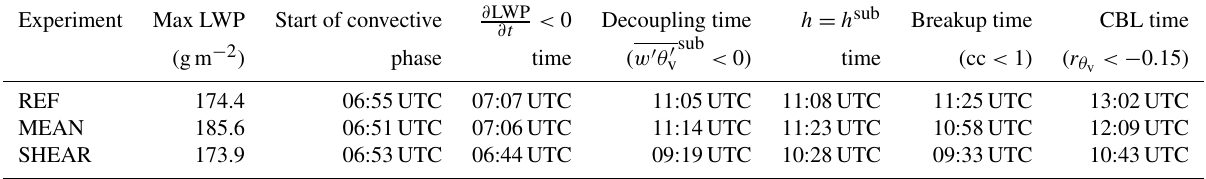
Table 1. Values and time of the main features in the stratocumulus-to-cumulus transition for the three experiments REF, MEAN and SHEAR. Experiment